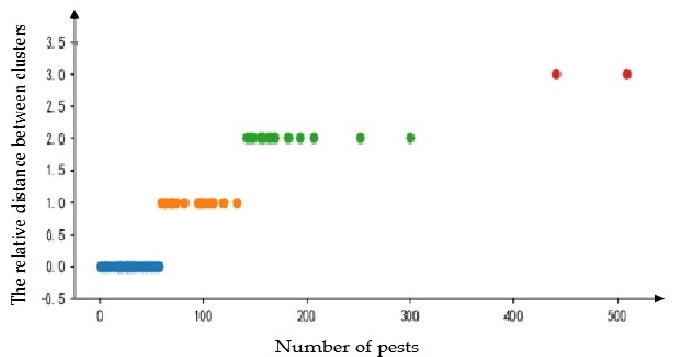
Figure 7. The Division of Pests in Vegetables in South China.